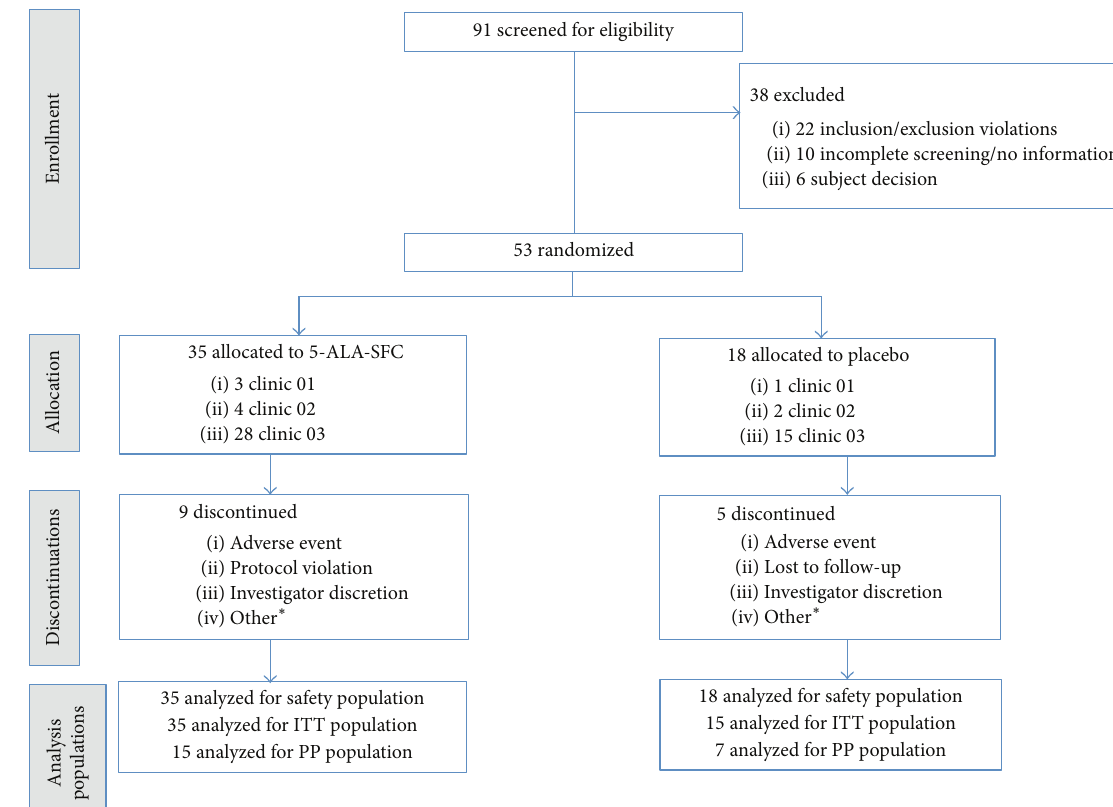
Figure 1: Patient disposition. ∗ includes noncompliance with dosing and inability to return for visits due to work and lack of